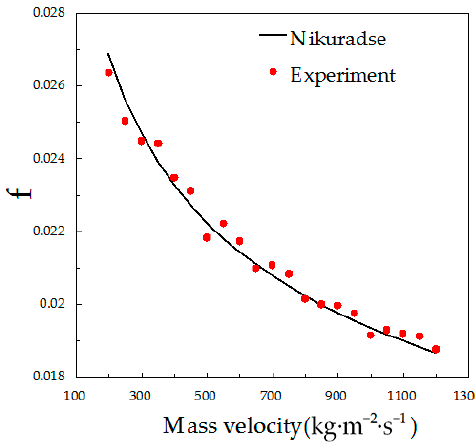
Figure 5. Comparisons of Nusselt (Nu) between experimental value and theoretical value for a single-phase flow. Energies 2017 , 10 , 1280